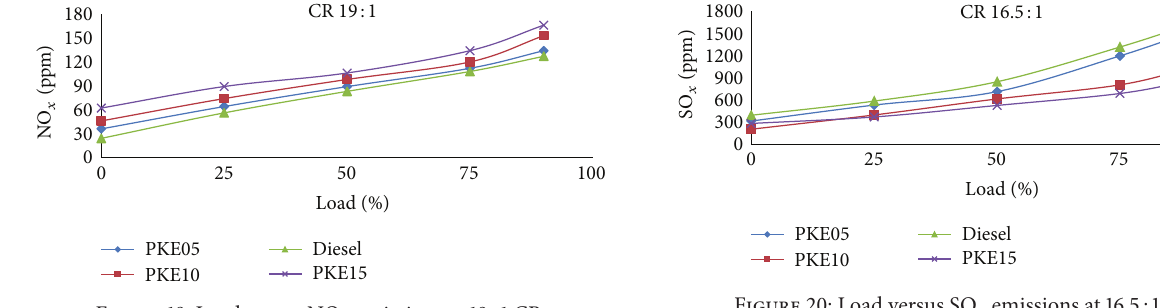
Figure 18: Load versus NO 𝑥 emissions at 19: 1 CR.